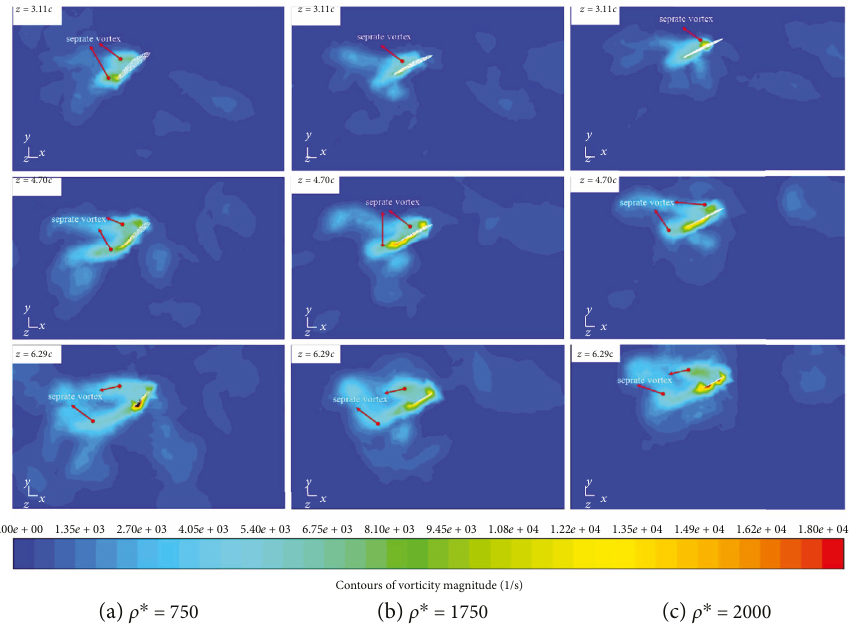
Figure 15: The vortex of the fl exible wing with ρ ∗ = 750 , 1750, and 2000 at t =0.30 T , z =3.11 c , 4.70 c , and 6.29 c .